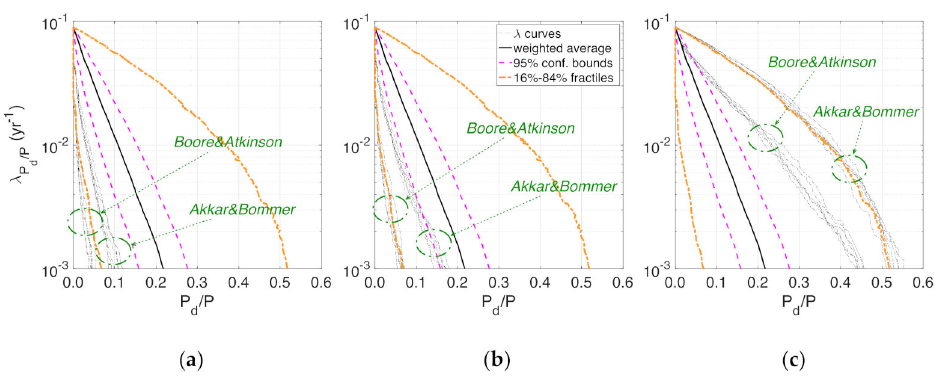
Figure 9. Disaggregation of total epistemic uncertainty in MAF curves of P d / P , according to the two adopted GMPEs and the fractiles of the RC fragility distribution: ( a ) 91.5%; ( b ) 50%; ( c ) 8.5%.